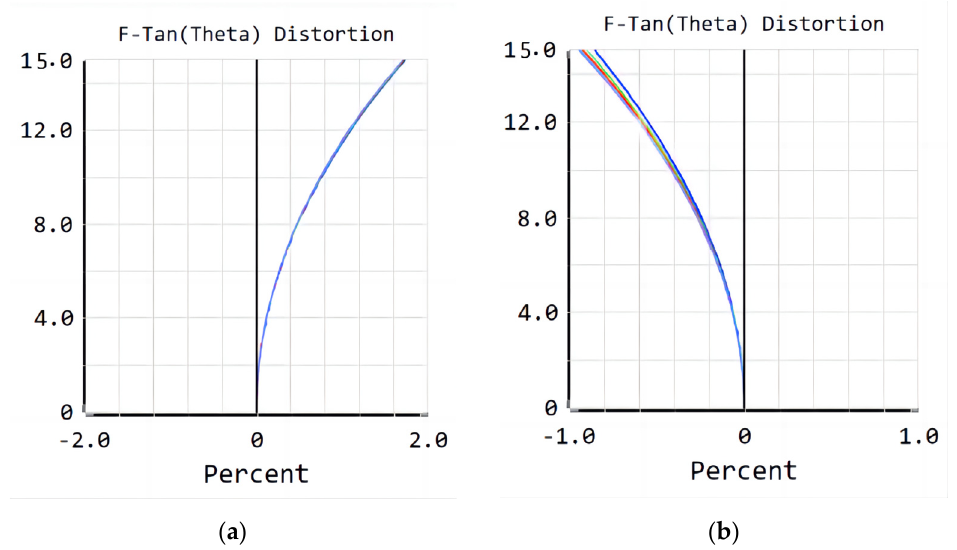
Figure 10. MTF of the ( a ) refractive lens system; ( b ) refractive/diffractive hybrid lens system. Figure 11 shows that the maximum distortion of the refractive/diffractive hybrid lens system is − 0.95% and the imaging distortion is smaller than that of the refractive lens sys- tem during use. The design results show that the optical performance of the refractive/dif- fractive hybrid lens system is higher than that of the refractive lens system.